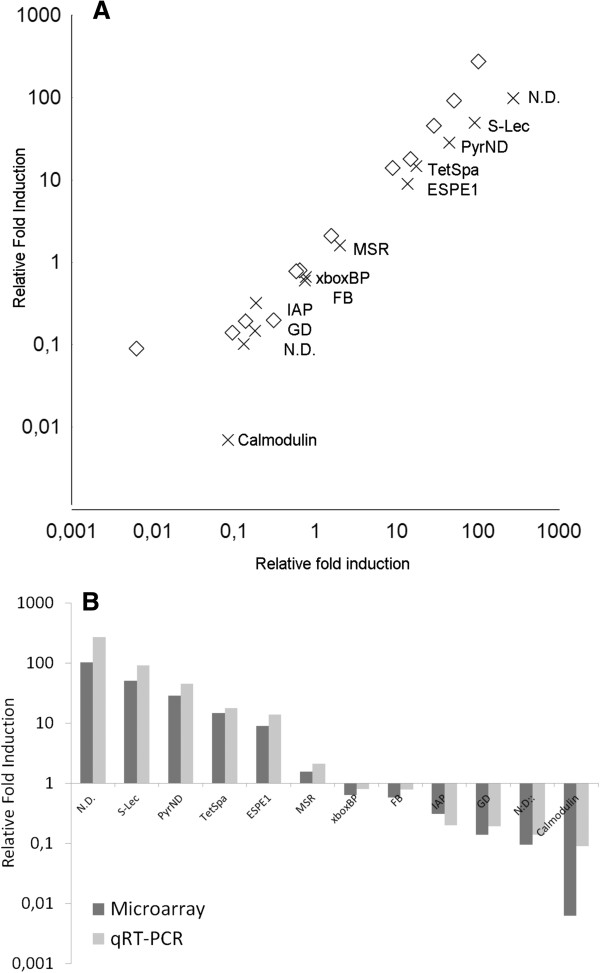
Combined plot representation (log scale) of Pearson correlation matrixes of microarray probe fold change (crosses) and respective qPCR (diamonds) (A) and Relative Fold Induction of microarray probe fold change (dark grey bar) and respective qPCR (light grey bar) (B) upon presence or absence of infection in selected sequences/probes. N. D. Stands for Sequence not determined, S-Lec for sialic acid-binding lectin; PyrND for pyridine nucleotide-disulphide oxidoreductase; TetSpafor tetraspanin, ESPE1 for Epididymal secretory protein E1: MSR for methionine sulfoxide reductase b3 isoform 2 isoform 1xboxBP for x-box binding protein 1; FB for fructose- -bisphosphatase; IAP for inhibitor of apoptosis protein; GD for glucose dehydrogenase and calmodulin.